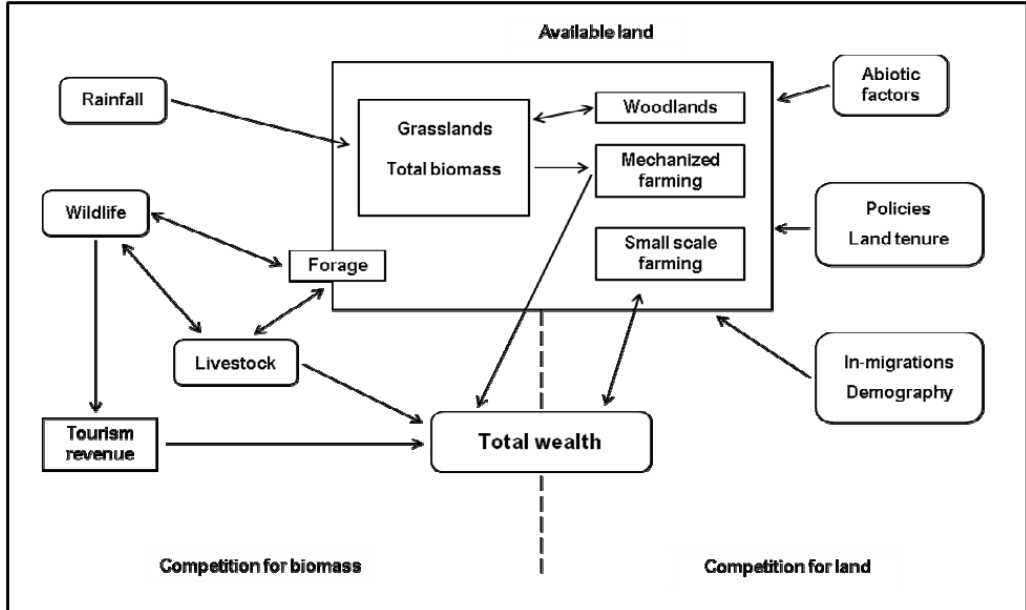
Figure 12. Conceptual model depicting the factors contributing to habitat loss and wildlife decline in the Masai Mara